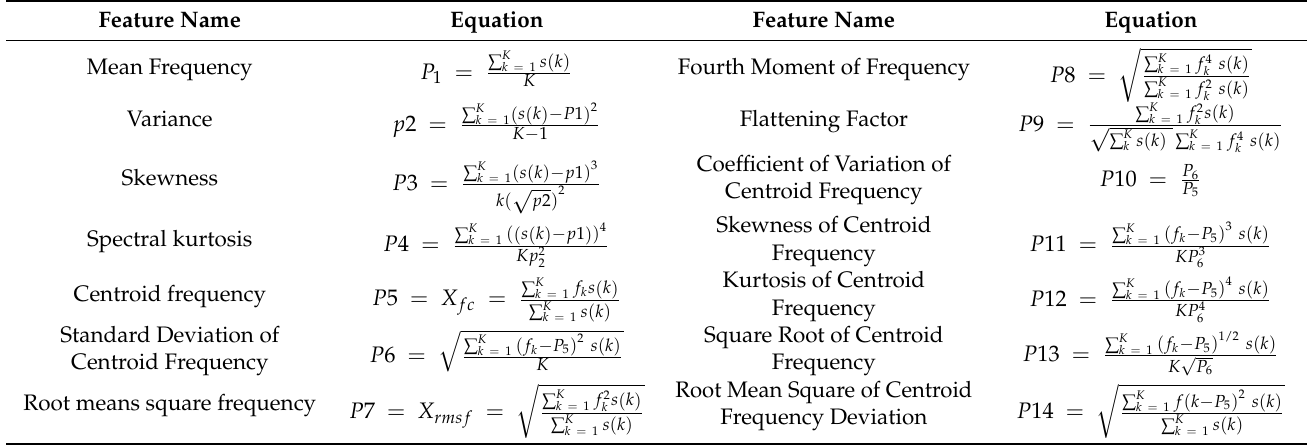
Table 3. Frequency domain features of AE